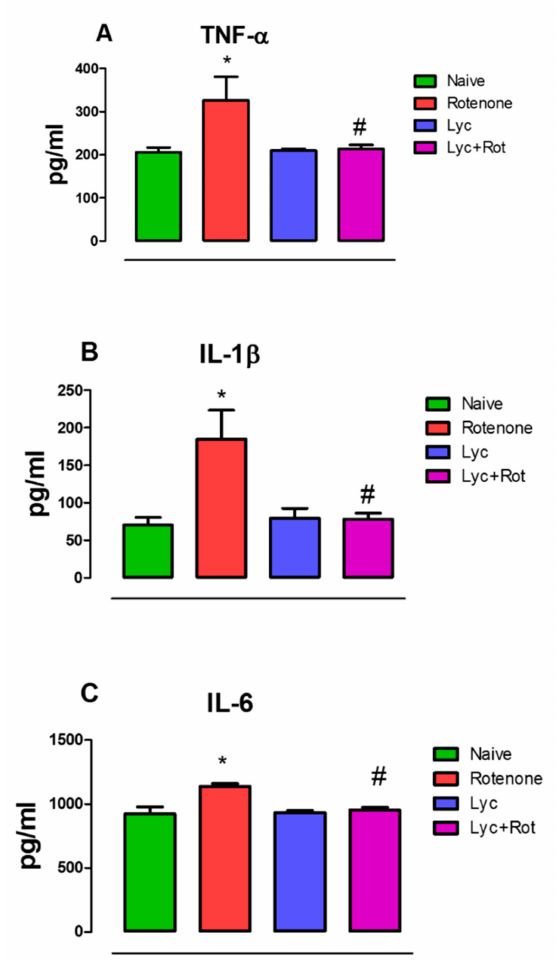
Figure3. ELISAanalysisofTNF- α ,IL-1 β andIL-6inexperimentalanimals.